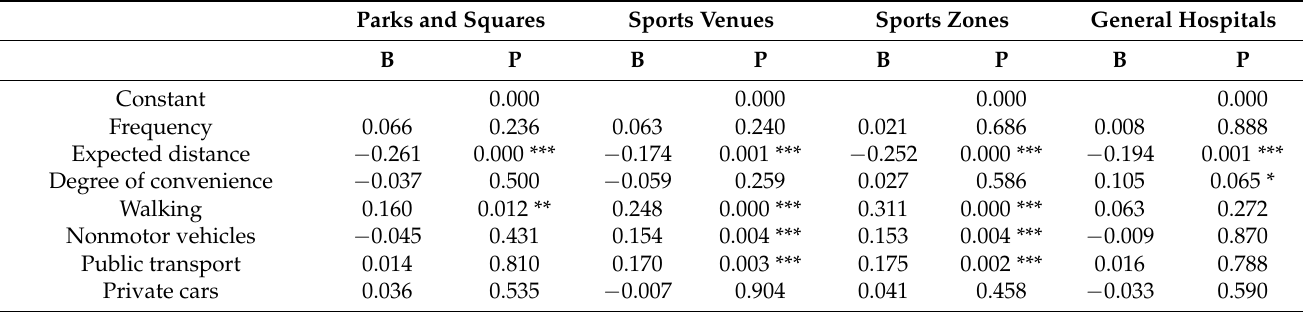
Table 7. Regression analysis of satisfaction with